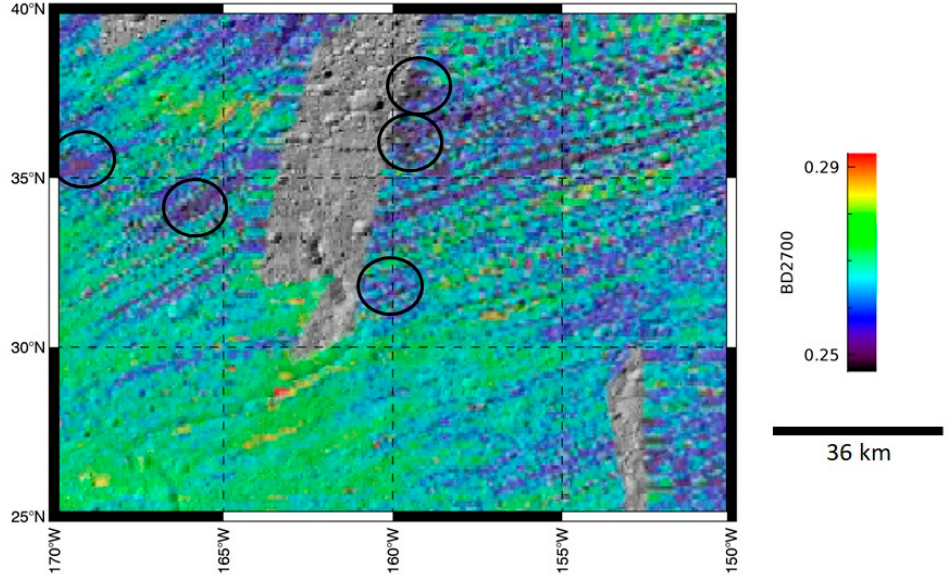
Figure 3. Spatial distribution of the 2.7 μ m band depth in the Junina Catenae region (cylindrical projection). Circles highlight linear features associated with shallowest bands. Scale bar refers to the latitude at the map center.